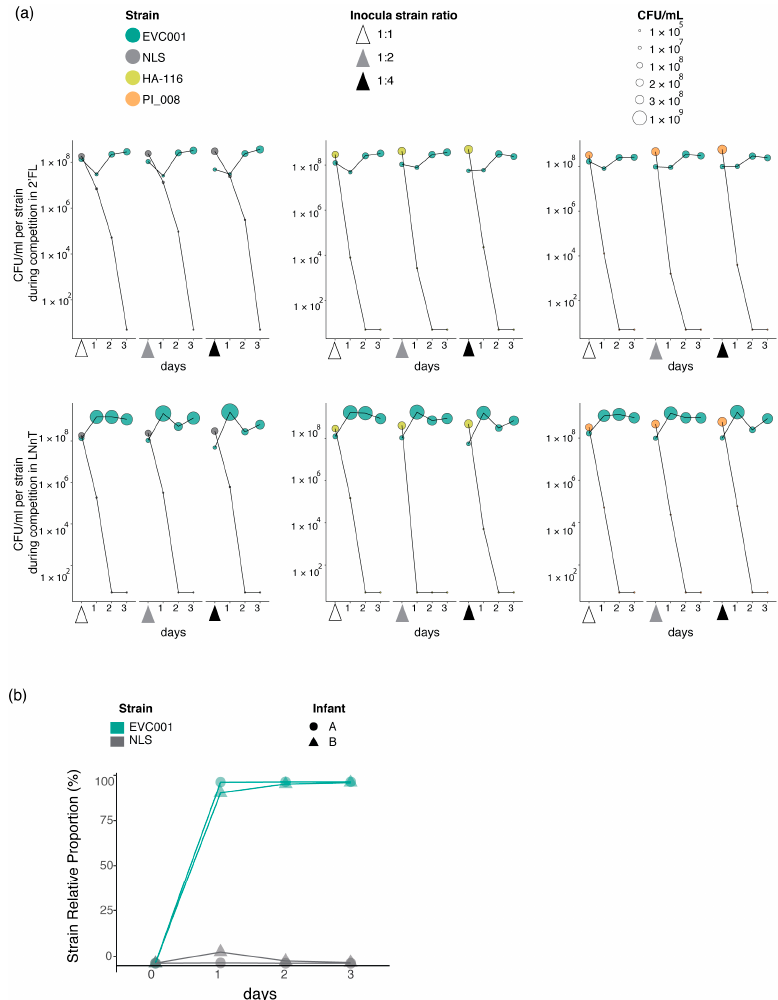
Figure 5. In vitro competition experiments and strain fitness in the breastfed infant gut. ( a ) In vitro growth experiments with varying rations of H5-negative to H5-positive strains in the inocula. Data represents the mean CFU / mL from three replicates. ( b ) Relative fitness (determined as proportion) of B. infantis NLS and B. infantis EVC001 in the fecal samples of two exclusively breastfed infants (A and B) before (day zero) and for three days after feeding the probiotic strains. For data analysis, if threshold cycle values were below detection limit, the bacterial abundance was recorded as the lowest dilution in the standard